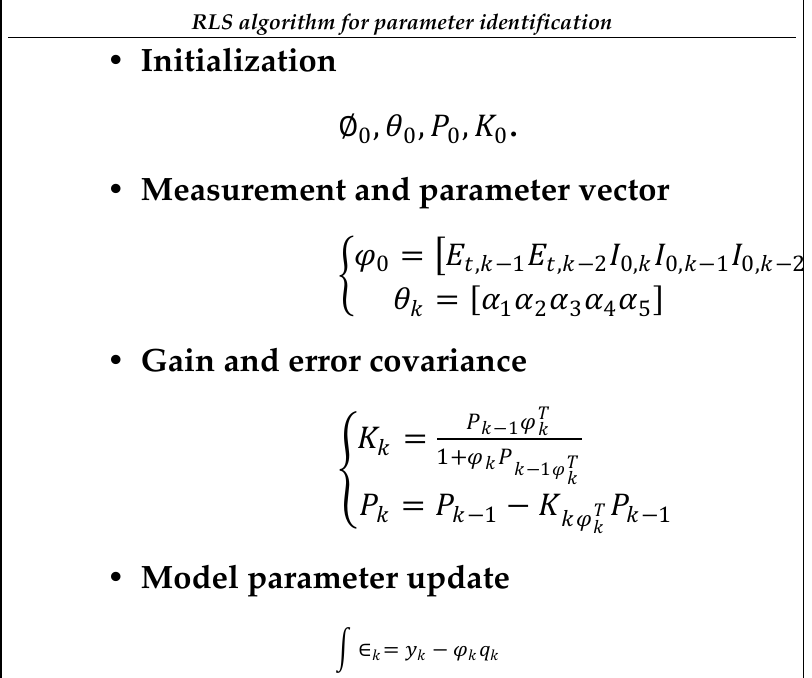
Figure 3. Model parameter identification based on the recursive least square algorithm.